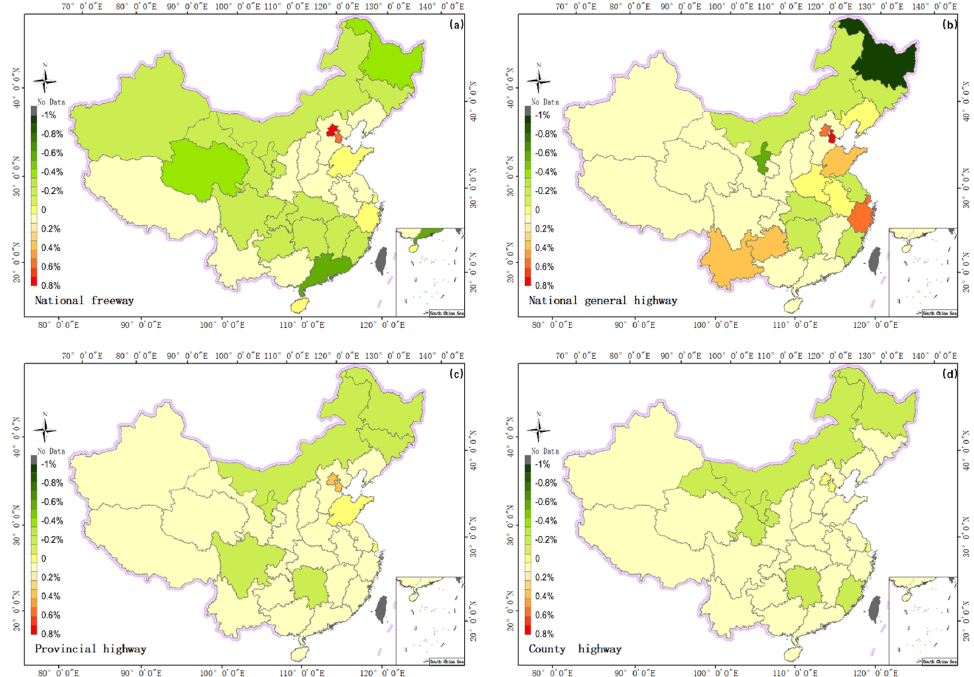
Figure 14. The highway tra ffi c prosperity temporal changes from 2015 to 2018: ( a ) is the tra ffi c prosperity temporal changes of national freeway; ( b ) is the tra ffi c prosperity temporal changes of national general highway; (c) is the tra ffi c prosperity temporal changes of provincial highway; ( d ) is the tra ffi c prosperity temporal changes of county